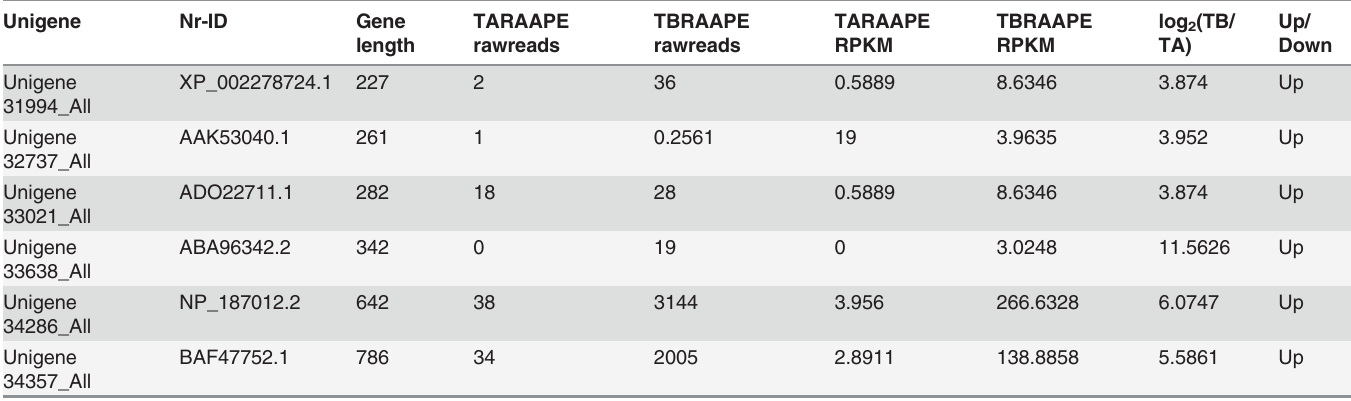
partial sequences were obtained by Genome walking and RACE technology. The eight full- length sequences of blueberry MATE transporters identified in this study were named VcMATE 9 as shown in Table 2, which also lists the accession number of their complete cDNA and the closest corresponding Arabidopsis genes.